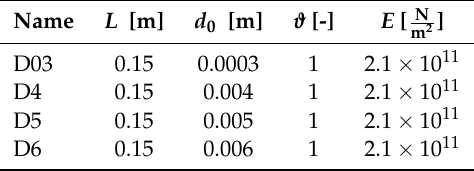
Table 1. Properties of the used sensor